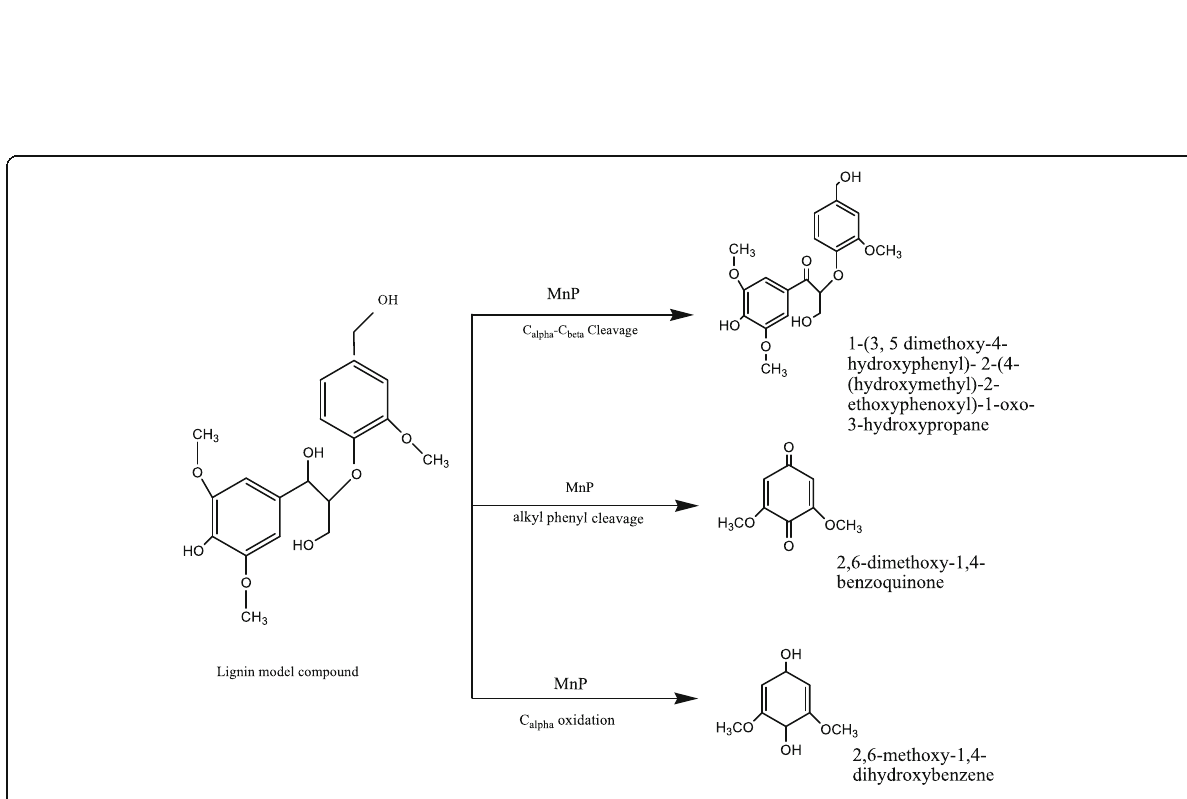
Fig. 3 Manganese peroxidase-catalyzed oxidation of lignin model compound (phenolic aryglycerol β -aryl